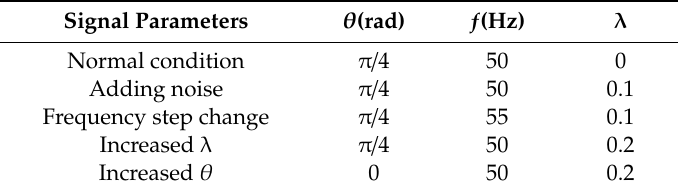
Table 1. Voltage parameters under different condition.